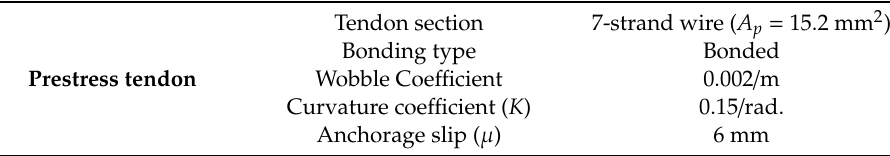
Table 2. Prestress tendon modeling